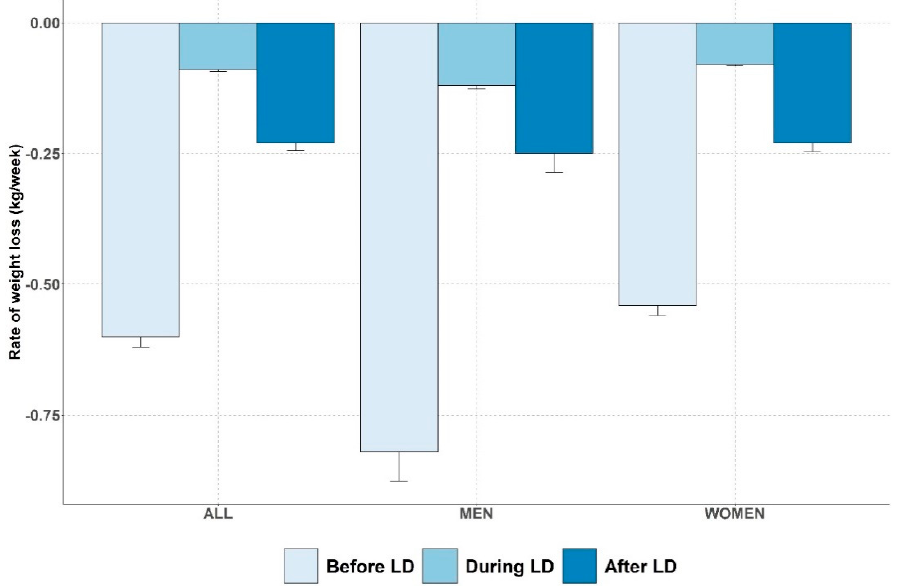
Figure 2. Rates of weight loss before, during and after COVID19 lockdown periods depicted for overall population and per gender. LD: lockdown. overall population and per gender. LD: Table 1. Description of weight loss and rate of weight loss before, during and after COVID19 lockdown periods.